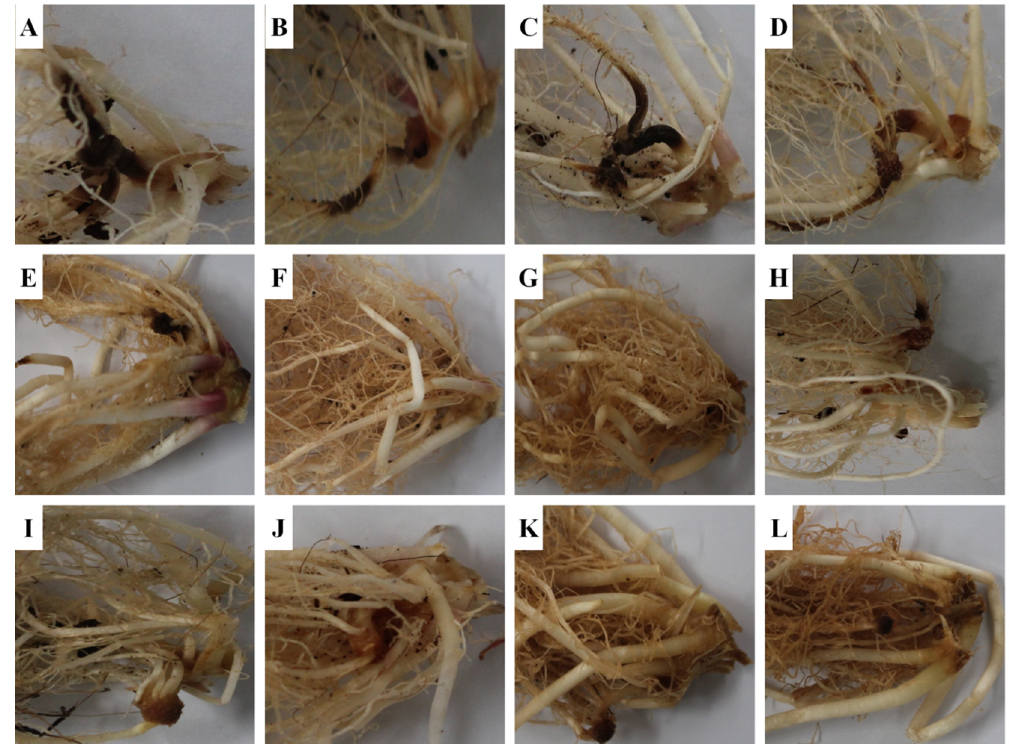
Figure 7. Pictorial view of roots of Korean maize cultivars infected with F . temperatum ( A , E , I ) Hikchal, ( B , F , J ) Mibeak-2ho, ( C , G , K ) Chahong-chal and ( D , H , L ) Oluckdehack-chal ( A – D = negative control, E – H = treated with strain KNU17BI2, I – L = treated with strain KNU17BI3) . Non-bacterized plants but pathogen-challenged were served as negative control.